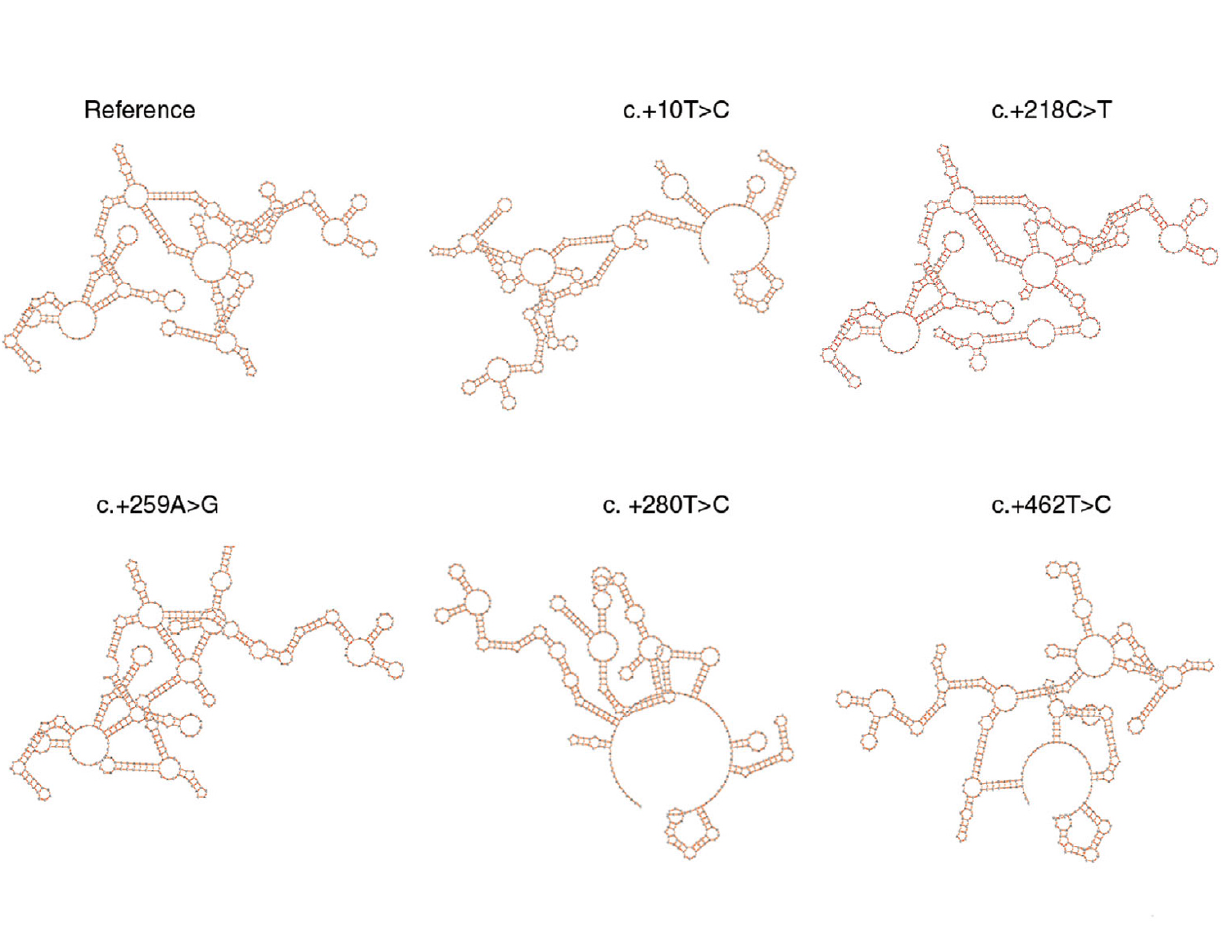
Figure 2 Effect of mutations in the 3'-UTR of GATA4 on mRNA folding. Using the program GeneQuest (Lasergene 6.0), the effect of sequence alterations on RNA folding was predicted using the first c.+500 nt in the 3'-UTR of GATA4 . GeneQuest uses the Vienna RNA folding procedure, taken from Zuker's optimal RNA folding algorithm [43], to fold the sense strand of selected DNA regions as RNA. Compared to the reference sequence, 7/9 mutations would result in faulty RNA folding, on which five patterns here are shown. Same pattern was observed for c.+10 T > C and c.+44T >